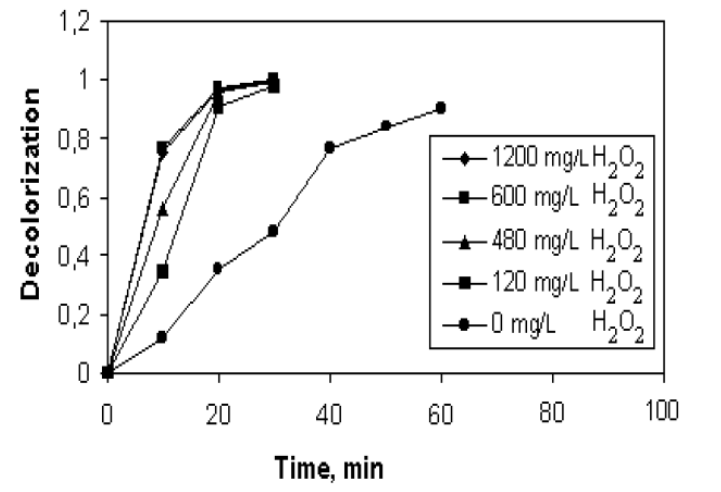
Fig. 3 Effect of H 2 O 2 concentration on the decolorization of Acid Red G azo dye. Initial conditions: C dye =50 mg/L, pH=5.68, t=20 o